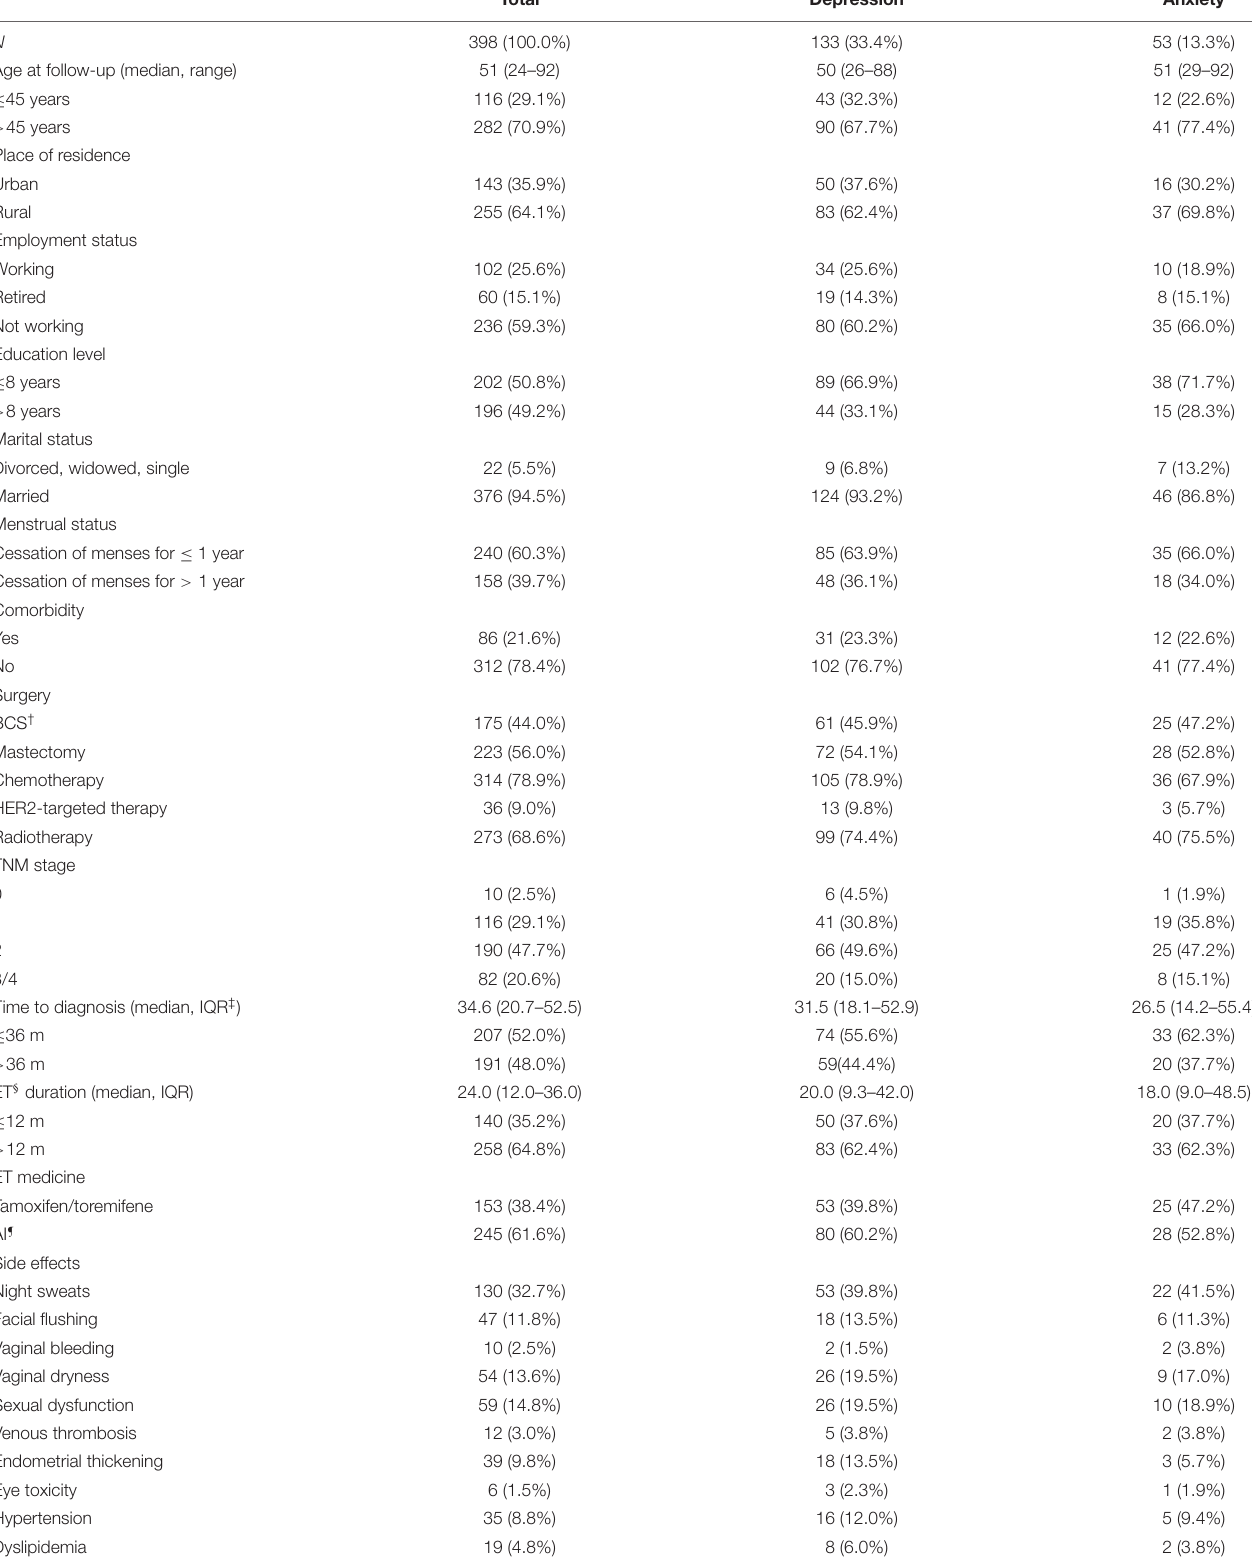
TABLE 1 | Demographic, disease-related characteristics, and side effects in total populations and depression/anxiety groups. Total